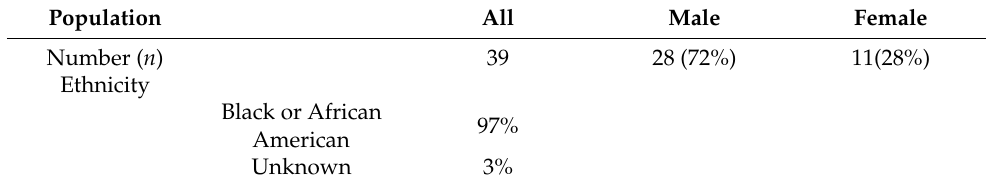
Table 4. Subject demographics, gender, age and ethnicity for study 2.